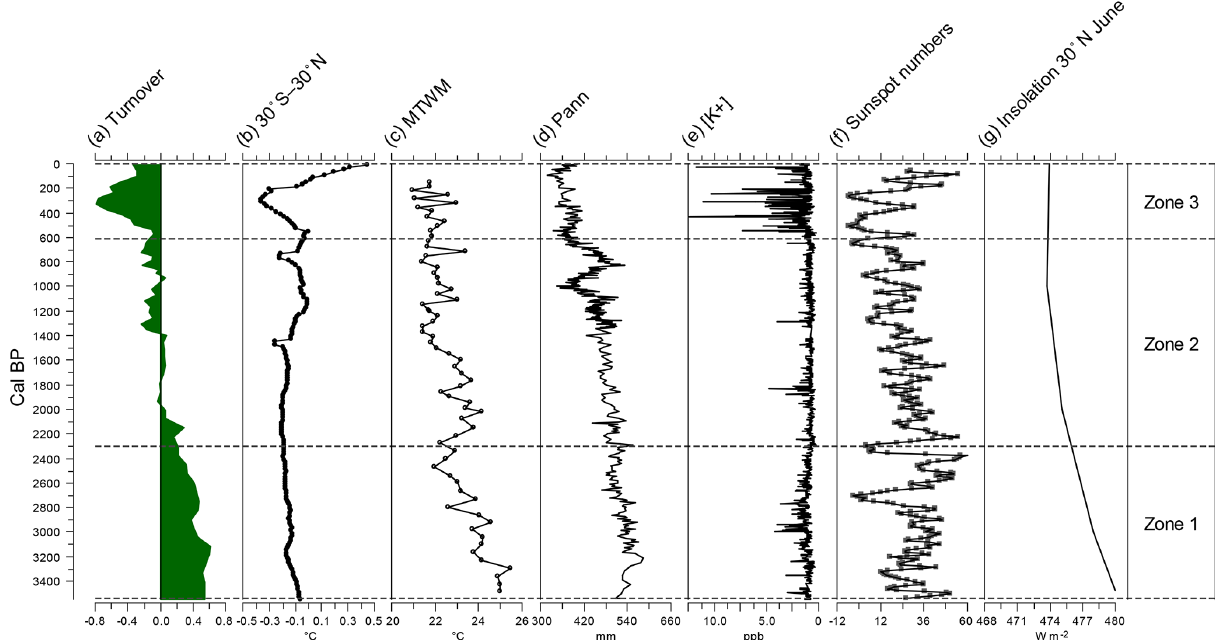
Figure 6. Compositional turnover (deviations around the mean) plotted alongside internal and external climate forcings: mean temperature stack records for low-latitude temperature anomalies (panel b ; Marcott et al., 2013); NE China pollen-inferred mean temperature warmest month (MTWM) (July) (panel c ; Stebich et al., 2015); trends in pollen-inferred mean annual precipitation (panel d ; F. Chen et al., 2015); K + concentrations in the GISP (Greenland Ice Sheet Project) ice core (panel e ; Mayewski et al., 2004); sunspot numbers (panel f ; Solanki et al., 2004); June solar insolation at 30N (Wm − 2 ) (panel g ; Berger and Loutre,